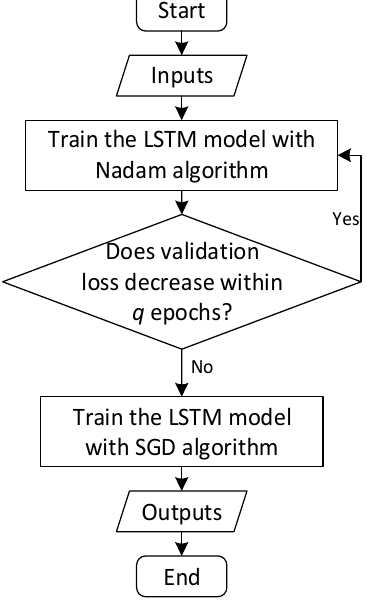
Figure 3. Flowchart of the hybrid Nadam-SGD algorithm.